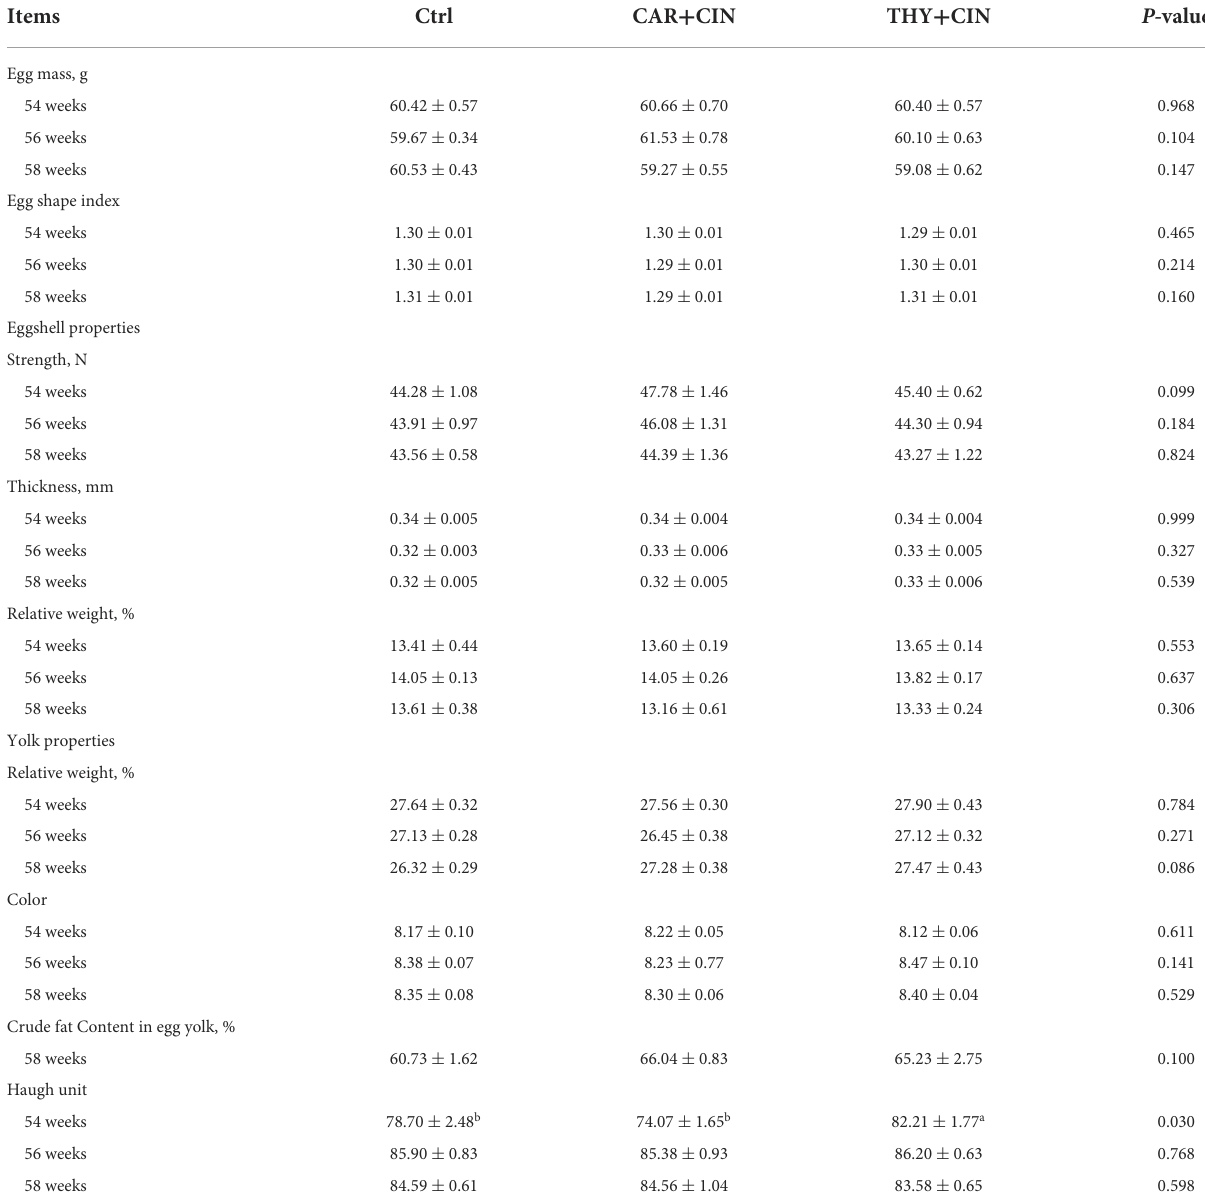
TABLE 6 Effects of dietary treatments on egg quality of post-peak laying